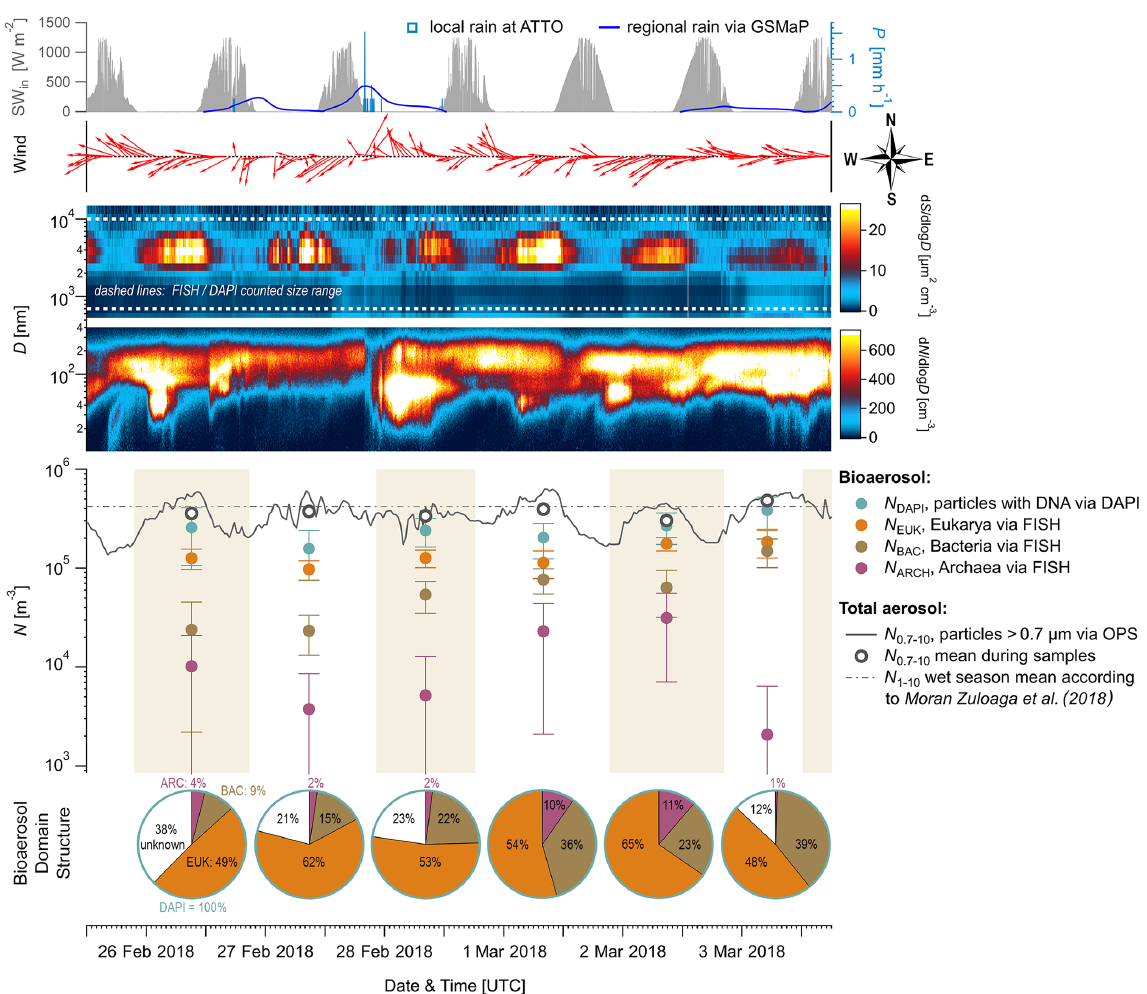
Figure 2. Time series of aerosol number concentrations and complementary aerosol and meteorological data at 60m height, observed over 6d during the wet season 2018. From top to bottom: (i) meteorological data including incoming solar radiation (SW in , grey shaded), precipitation rates ( P , blue curve and bars), and wind vectors (red arrows), (ii) contour plots displaying total aerosol number size distributions obtained by a scanning mobility particle sizer (0.01 to 0.4µm) and an optical particle sizer (0.5 to 10µm), (iii) bioaerosol number concentrations at the domain level from FISH and DAPI staining (markers as mean and error bars as 1 standard deviation) with shaded areas as filter sampling periods (each approx. 23h), and (iv) pie charts showing daily bioaerosol mixture based on number concentrations at the domain